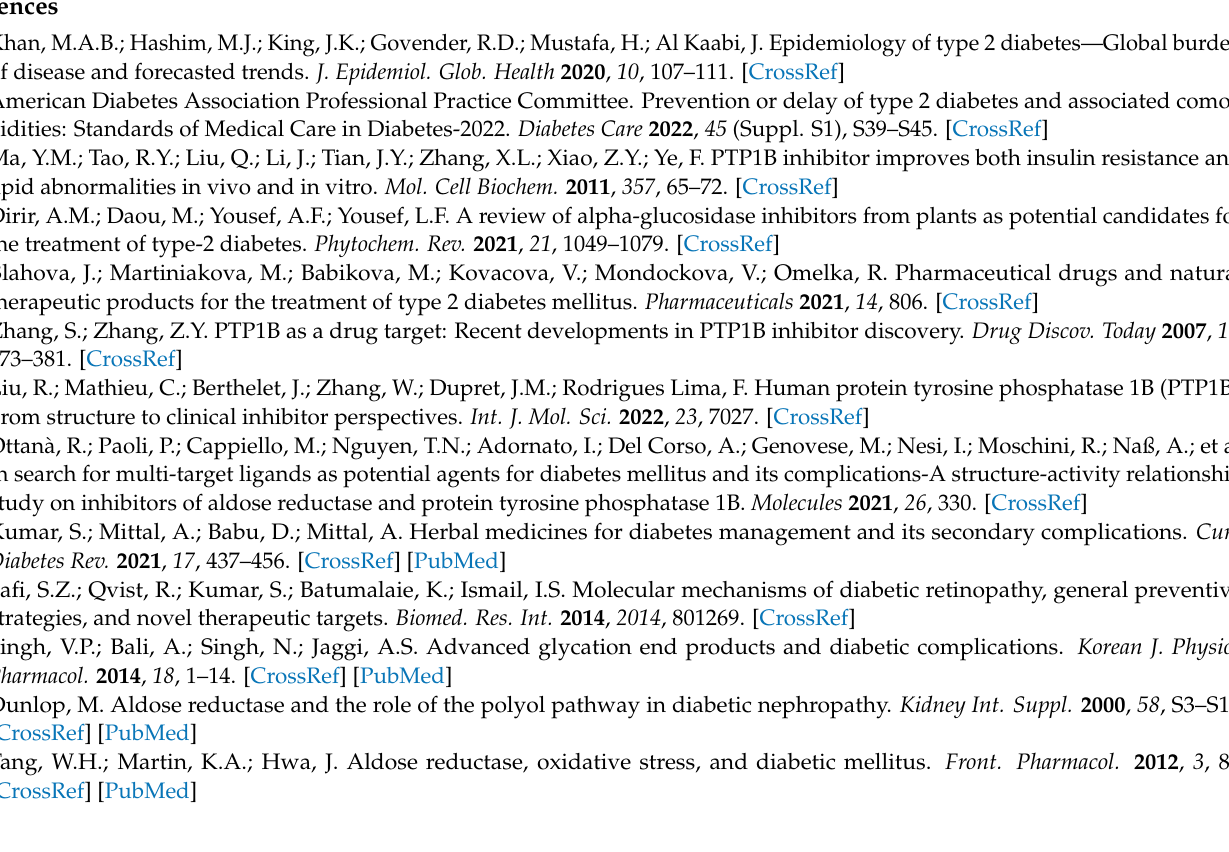
formation; Table S2: NMR spectra of isolated compounds 4 and 6 . Table S3. The 1D NMR data of compounds 7 and 8 . Figure S1. The NMR chromatograms of compound 4 . Figure S2. The NMR chromatograms of compounds 6 , 7 , and 8 . Table S4. The 1D NMR data of compounds 1 – 3